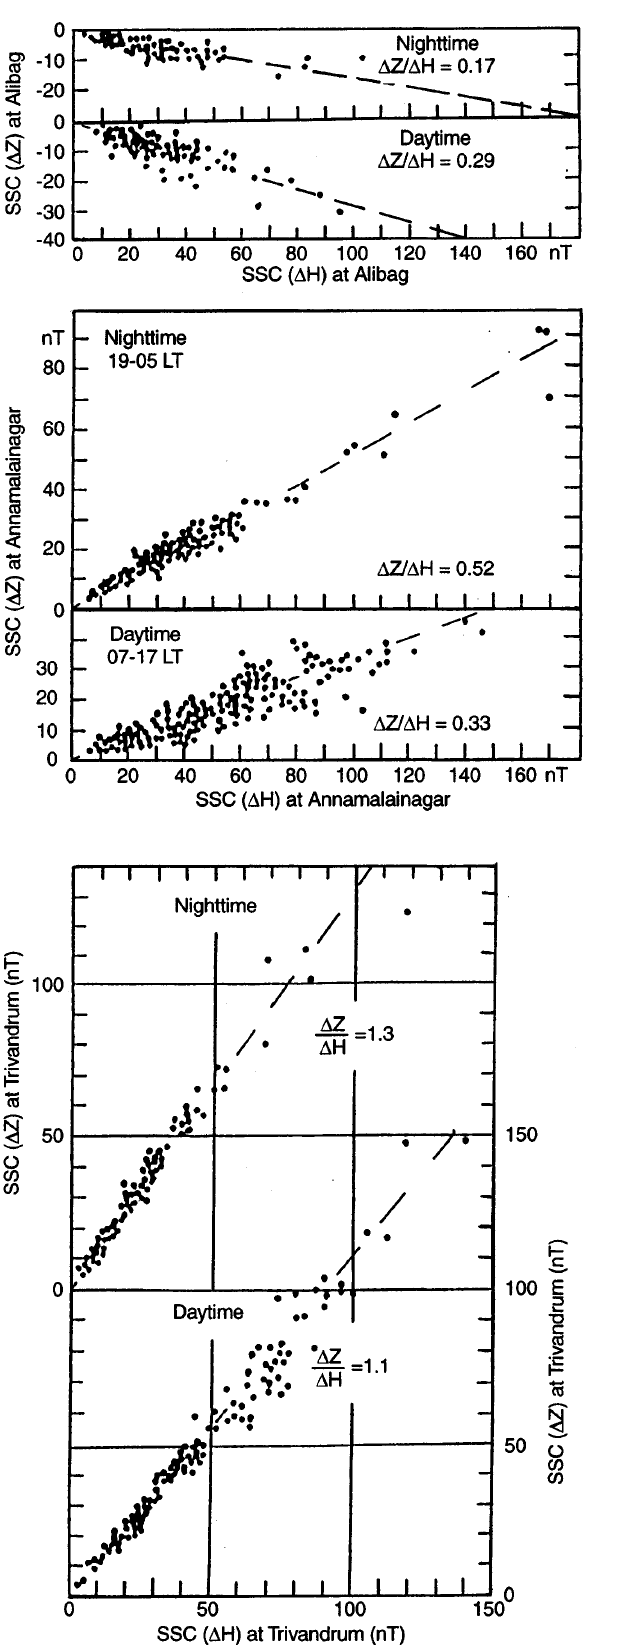
Fig. 10. Histograms for the direction of SSC disturbance vector sin ) 1 ( D Y/ D H) at TRD , KOD , ANN and